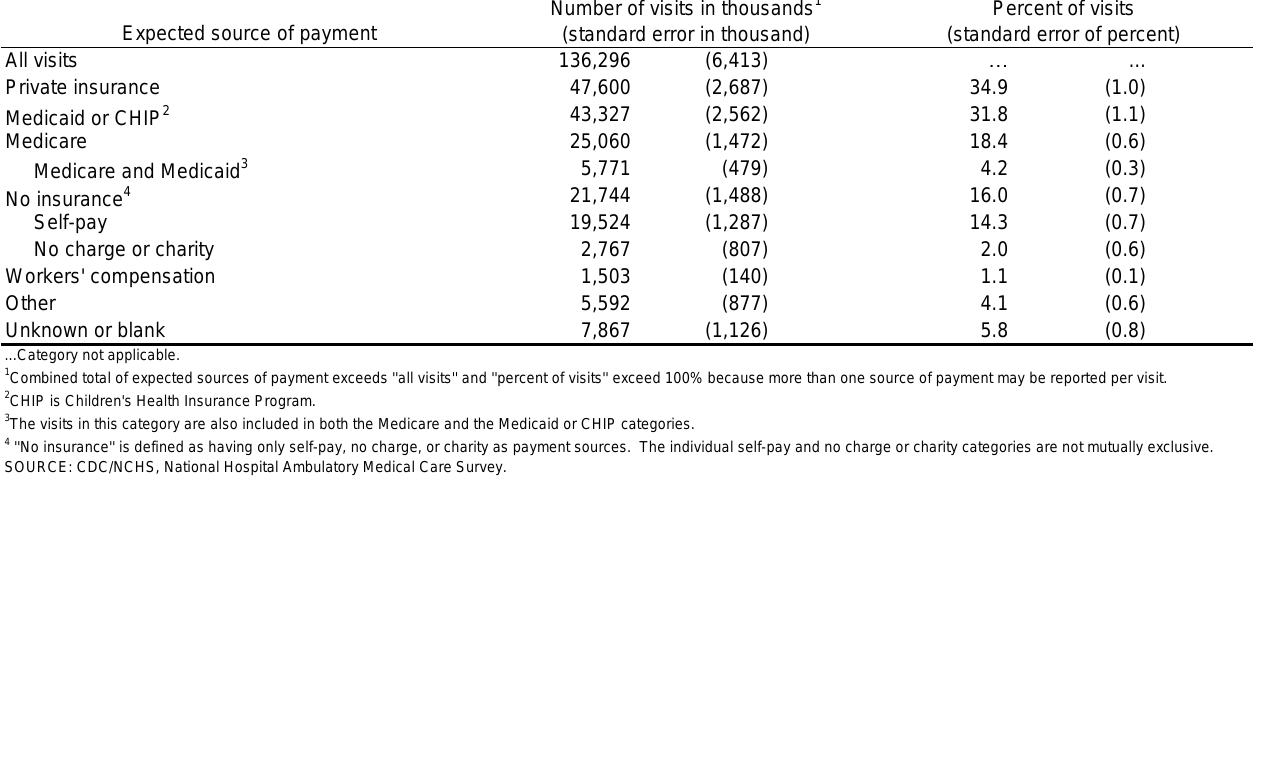
Table 6. Expected source(s) of payment at emergency department visits: United States, 2011